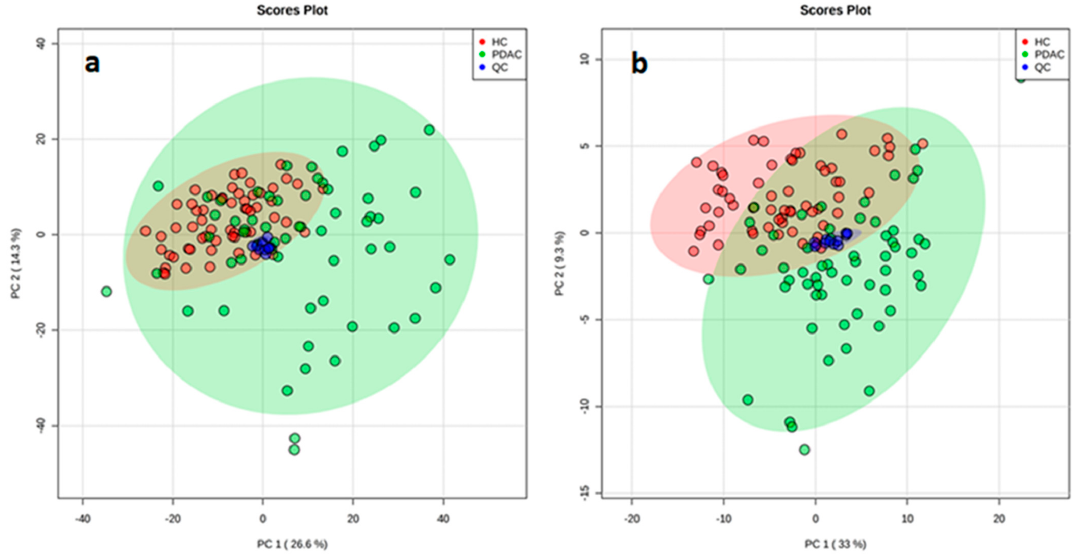
Figure 1. Principal component analysis score plots reveals a close clustering of the quality control (QC) samples by ESI+ ( a ) and ESI- ( b ) modes.